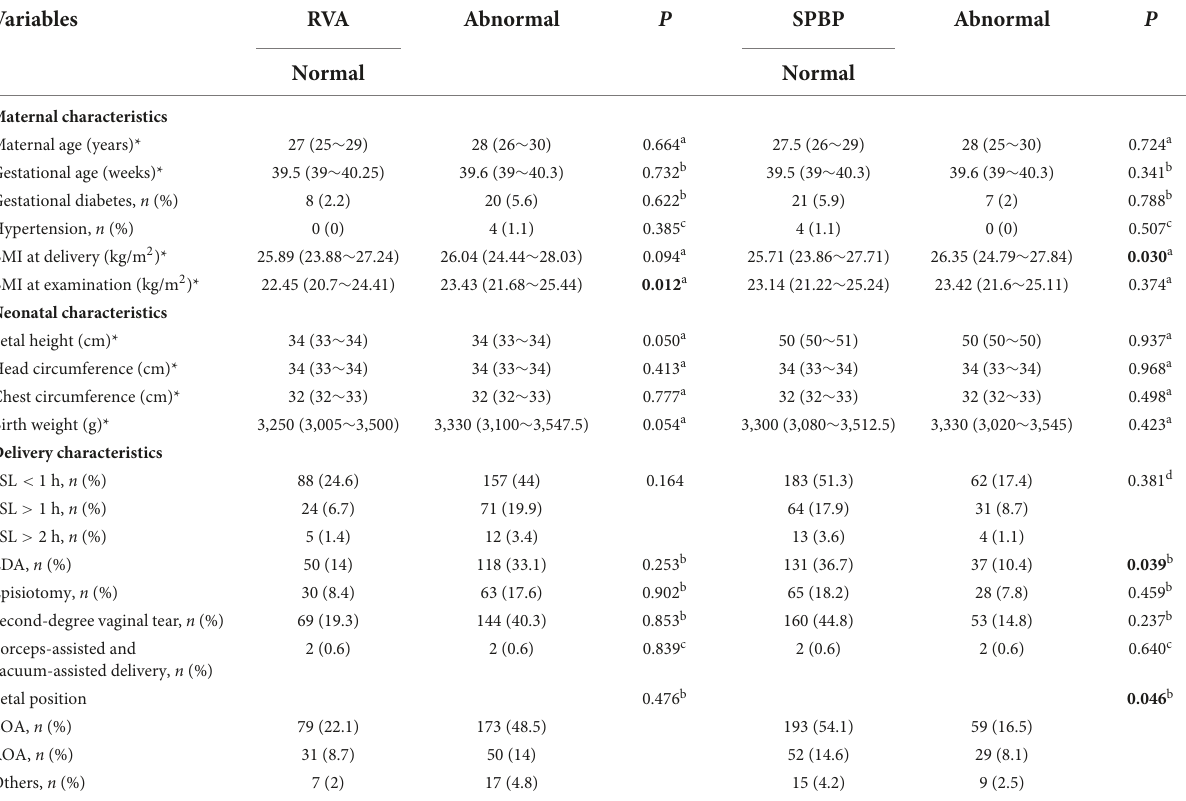
TABLE 2 Analysis of factors associated with retrovesical angle (RVA) and symphysis pubis to the posterior wall of the bladder (SPBP). Variables RVA Abnormal P SPBP Abnormal P Normal